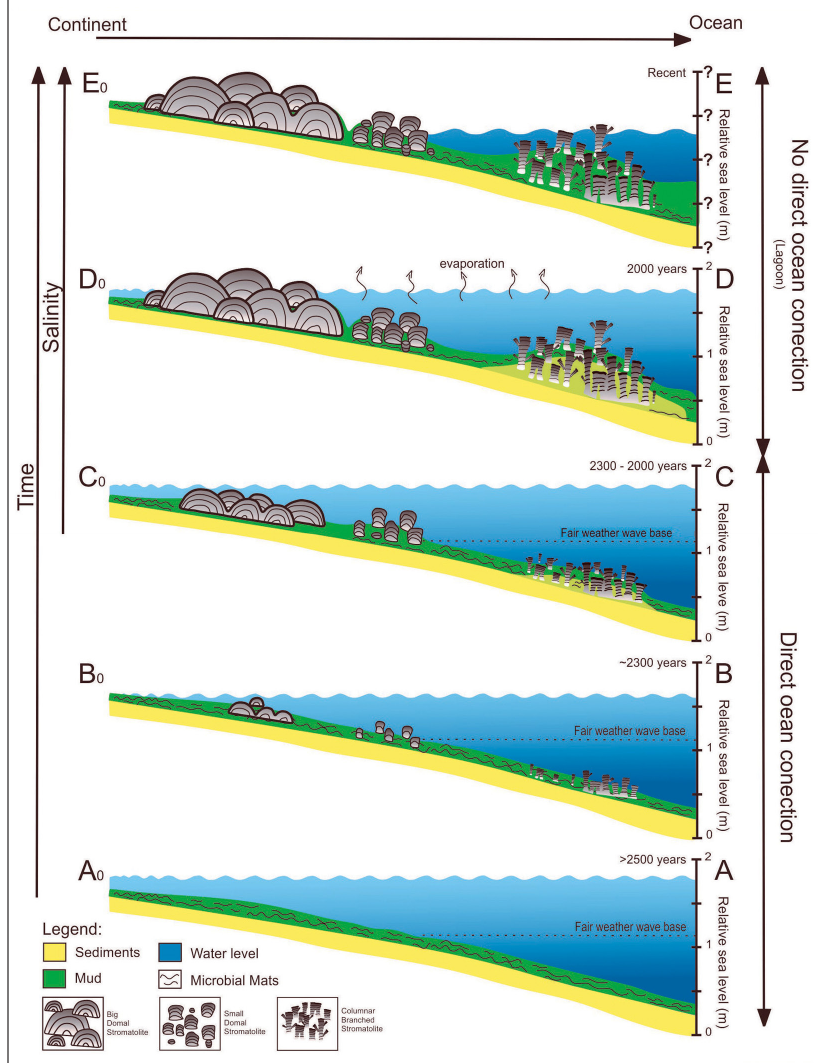
Figure 11 - Evolutionary model for stromatolites of Lagoa Salgada, demonstrating growth of the biostructures and environmental and chemical modifications over time (Adapted from Silva